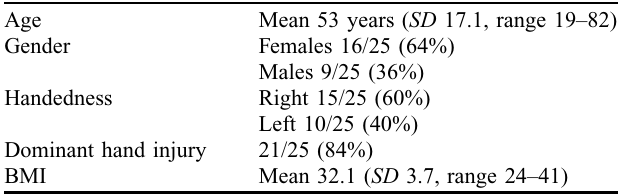
Table 1. Patient demographics in non-invasive fixator group.